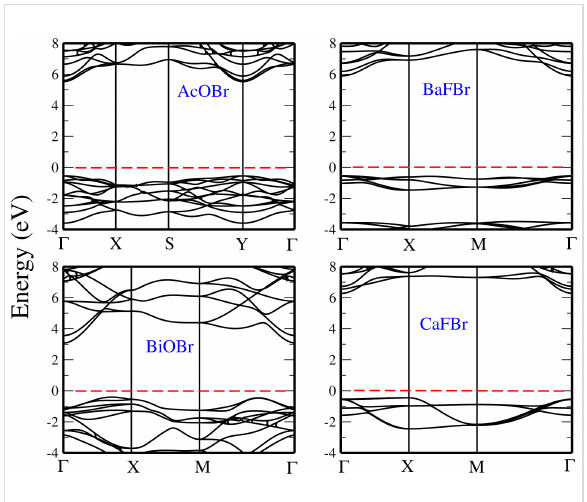
Figure 7: Band structures of monolayers AcOBr, BaFBr, BiOBr, and CaFBr, using the HSE functional. The Fermi level is set to 0 eV.